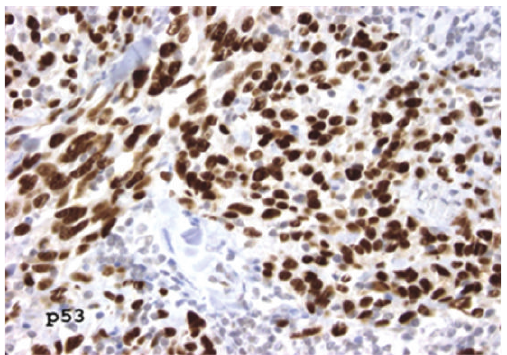
Figure 5: Although significant p53 staining was present in a quarter of the sporadic angiosarcomas as depicted, none of the radiation- associated tumors were positive (immunoperoxidase, 400x).